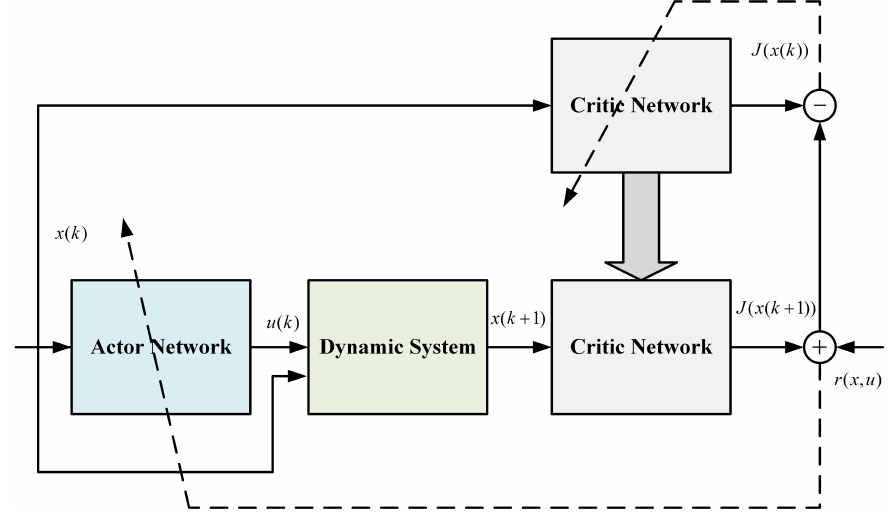
Figure 1. The basic structure of